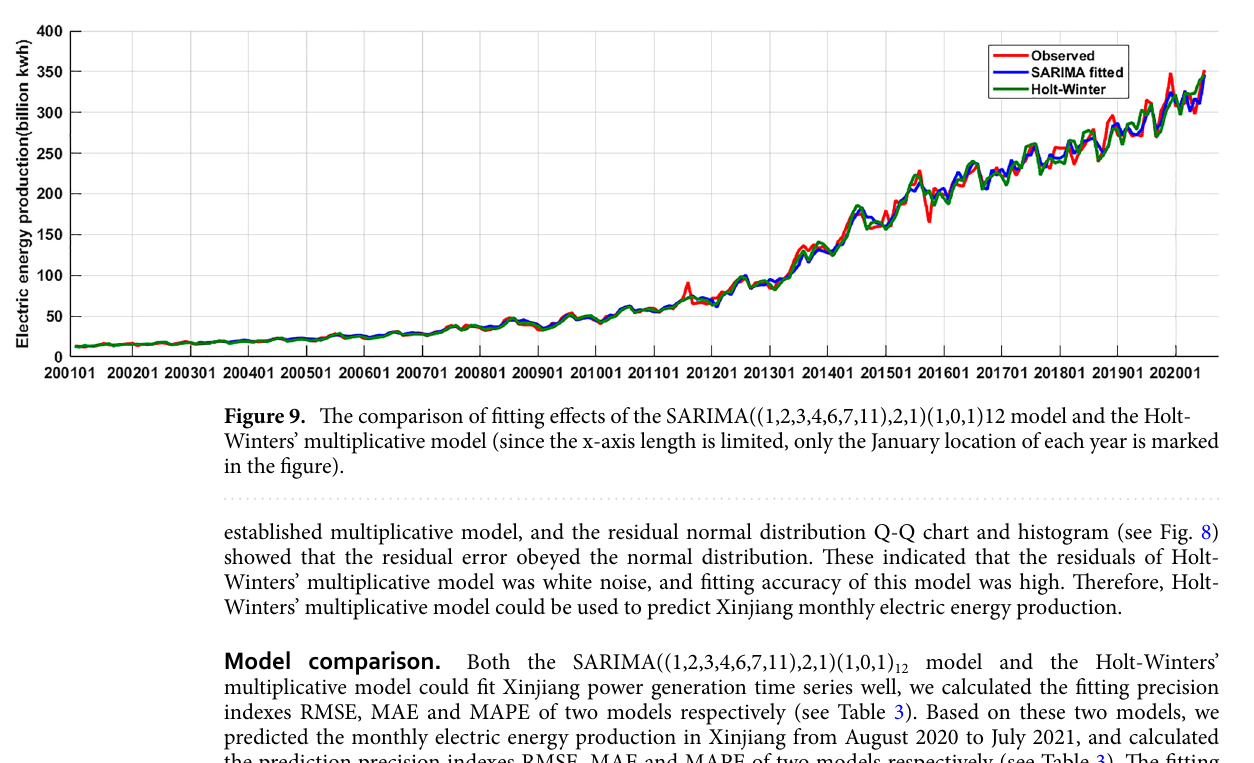
Table 3. The fitting and prediction accuracy values of SARIMA((1,2,3,4,6,7,11),2,1)(1,0,1) 12 model and Holt- Winters’ multiplicative model.